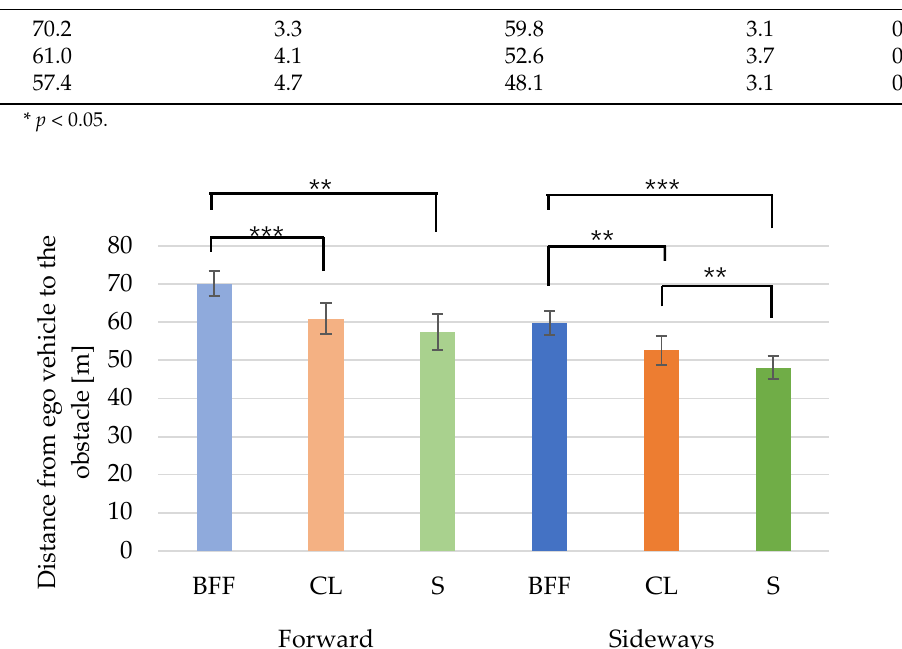
Figure 6. Leg posture comparisons of distance from the ego vehicle to the obstacle. ∗∗ p < 0.01/ ∗∗∗ p < 0.001.